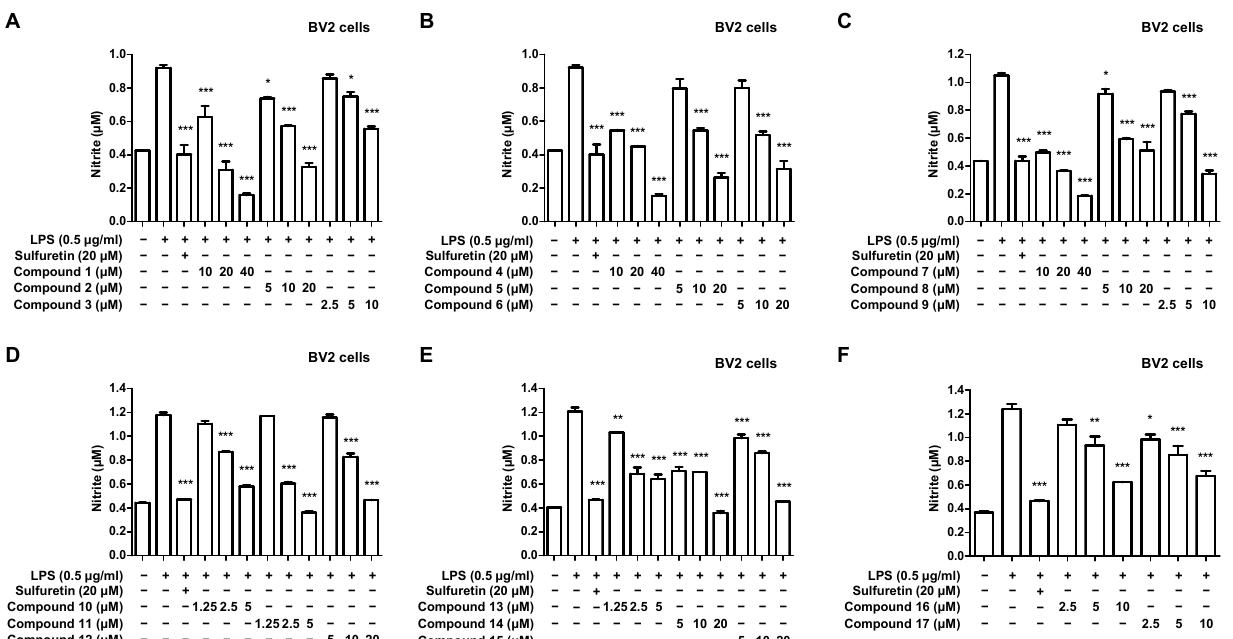
concentration-dependent manner (Figure 3).